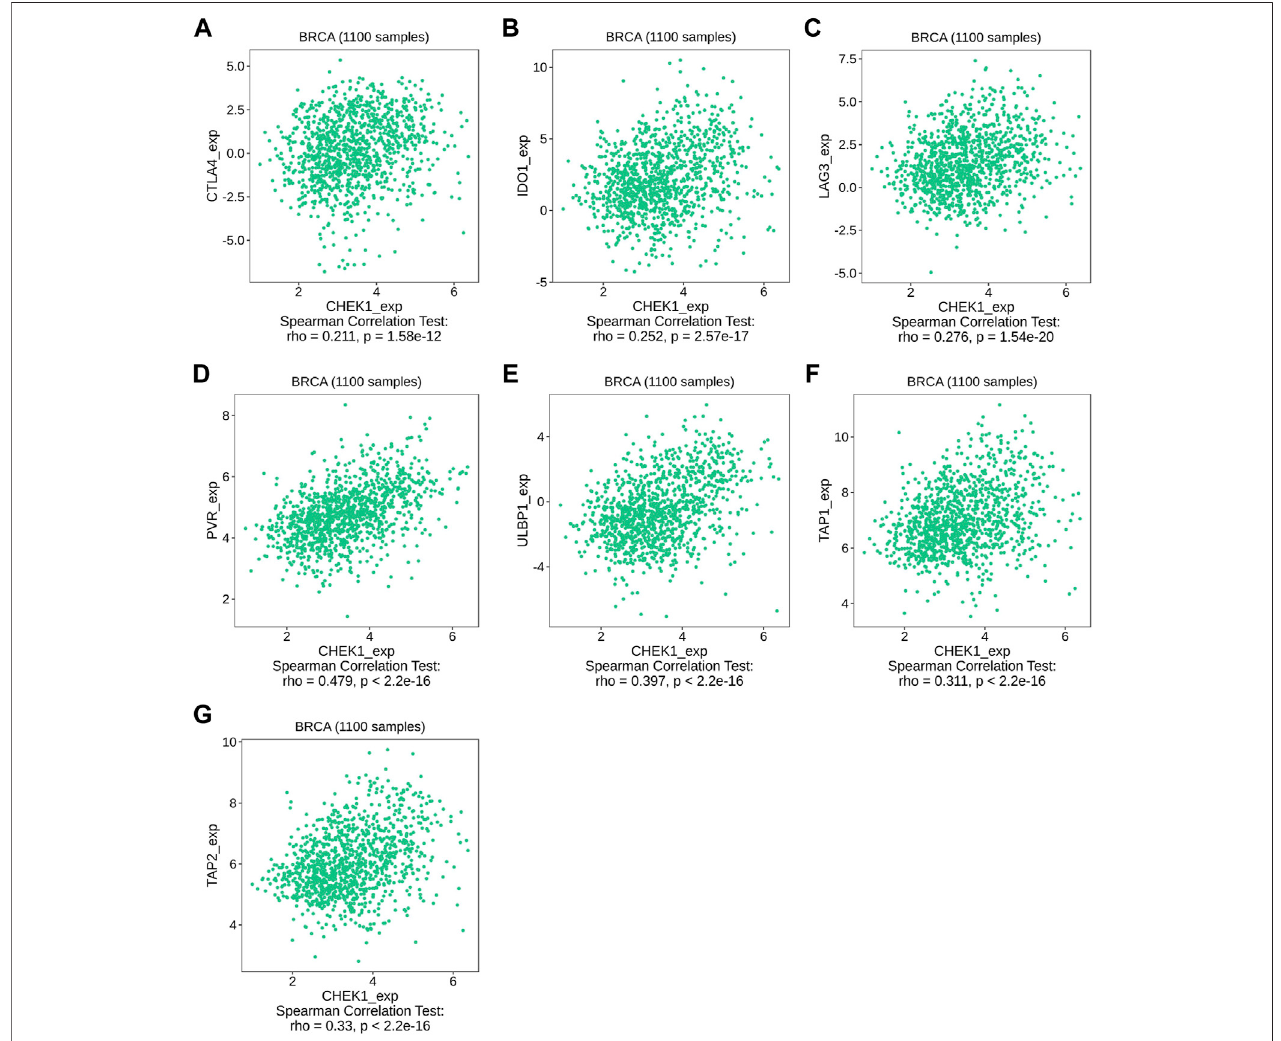
FIGURE 8 | Relations between the expression of CHEK1 and immune checkpoints in BRCA. (A – C) Relations between three immunoinhibitors (CTLA4, IDO1, LAG3) and expression of CHEK1. (D,E) Relations between two immunostimulators (PVR and ULBP1) and expression of CHEK1. (F,G) Relations between two MHC molecules (MHC_TAP1 and MHC_TAP2) and expression of